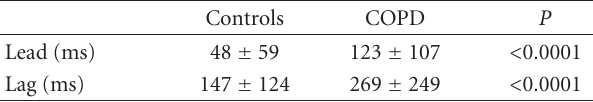
Table 2: The means ± standard deviations of lead and lag.